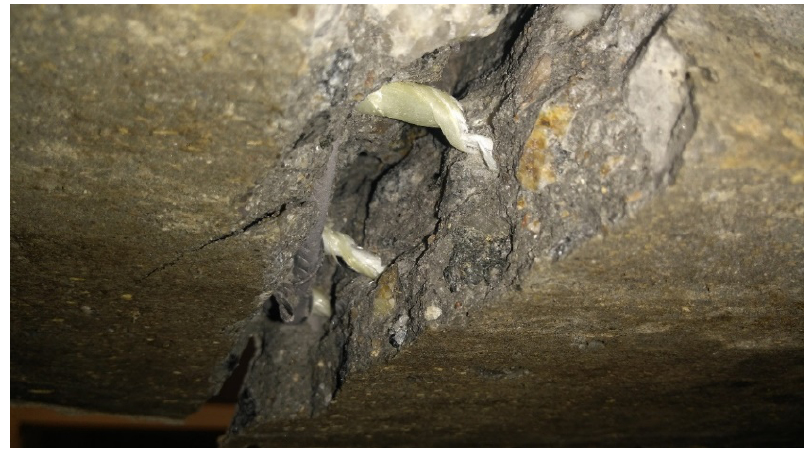
Figure 7. Rupture of the GFRP bars of the VV23.